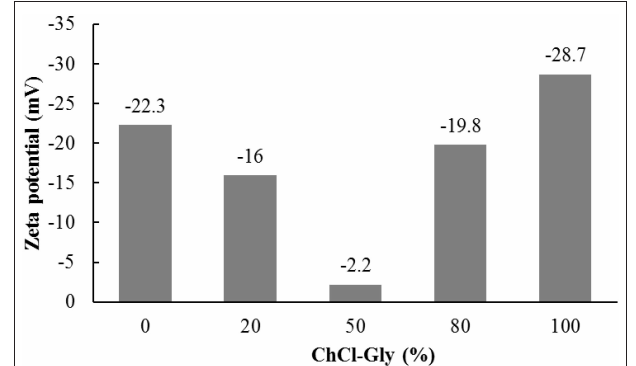
FIGURE 8 | Zeta potential of SWNTs at various ChCh-Gly (mass% in water) concentrations. The negative surface charge of SWNTs decreased and then increased with the increase of ChCh-Gly (mass% in water). The surface charge of SWNTs almost neutralized ( − 2.2mV) at 50% ChCh-Gly probably due to the disintegration of ChCh-Gly DES into its